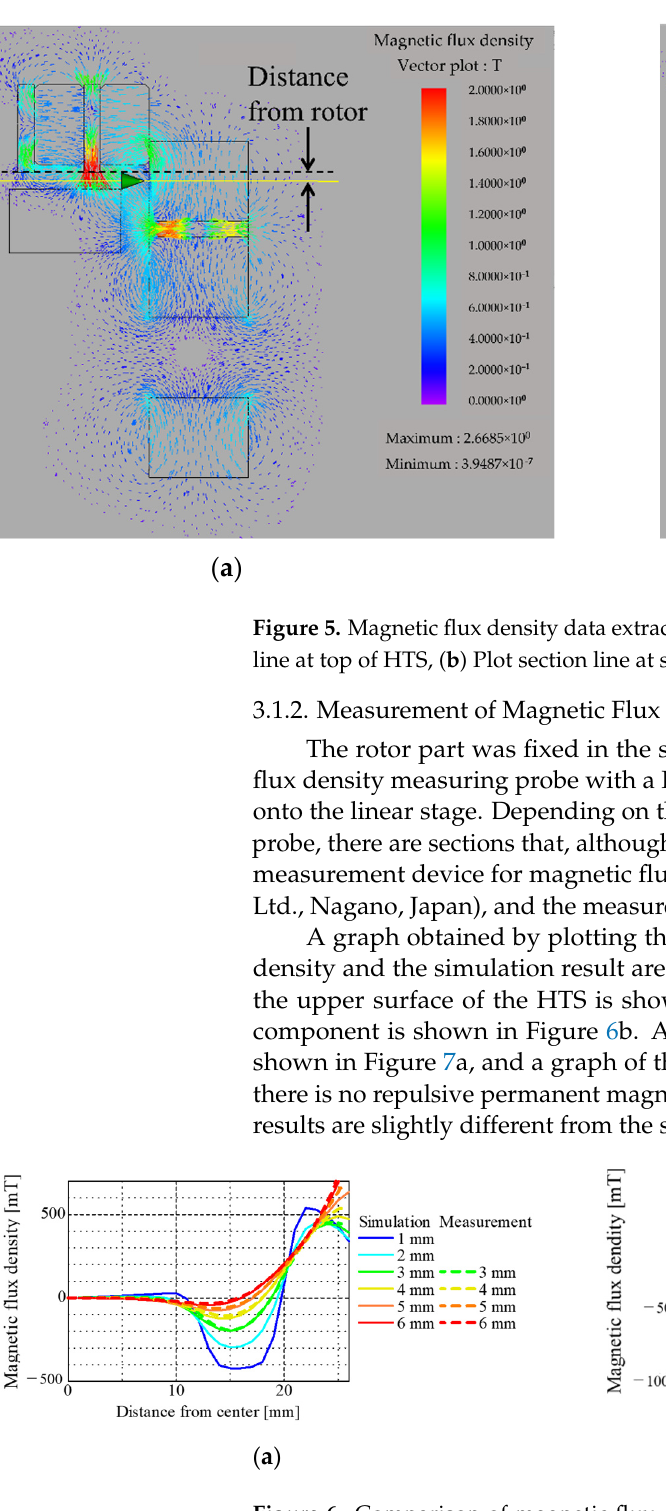
Figure 6. Comparison of magnetic flux density at the top of the HTS. ( a ) Radial simulation and measurement results, and ( b ) axial simulation and measurement results.